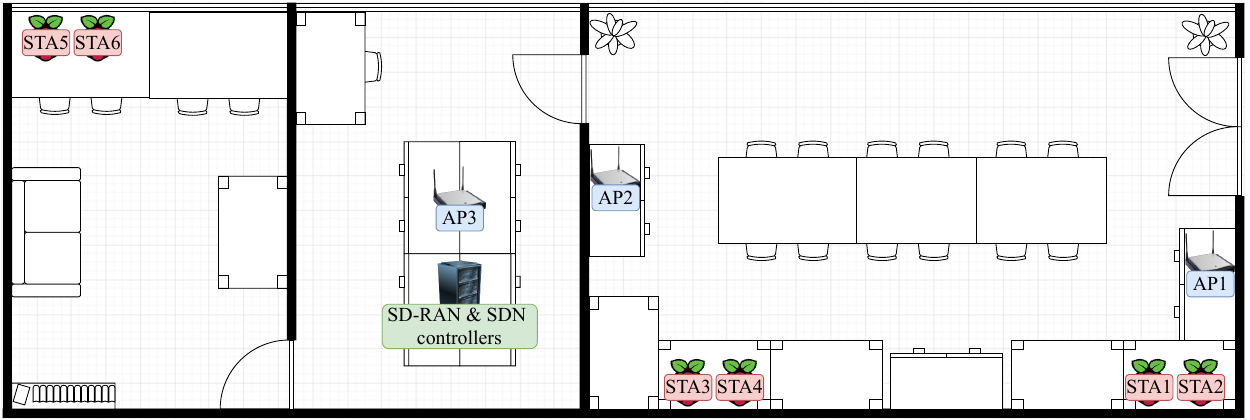
Figure 6. Testbed deployment